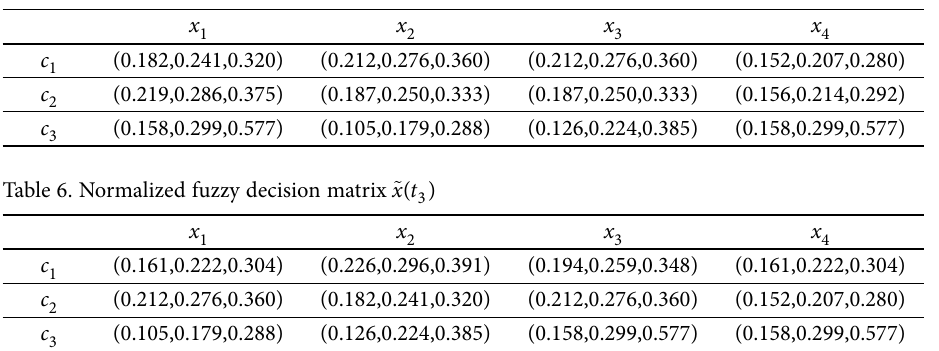
Table 5. Normalized fuzzy decision matrix